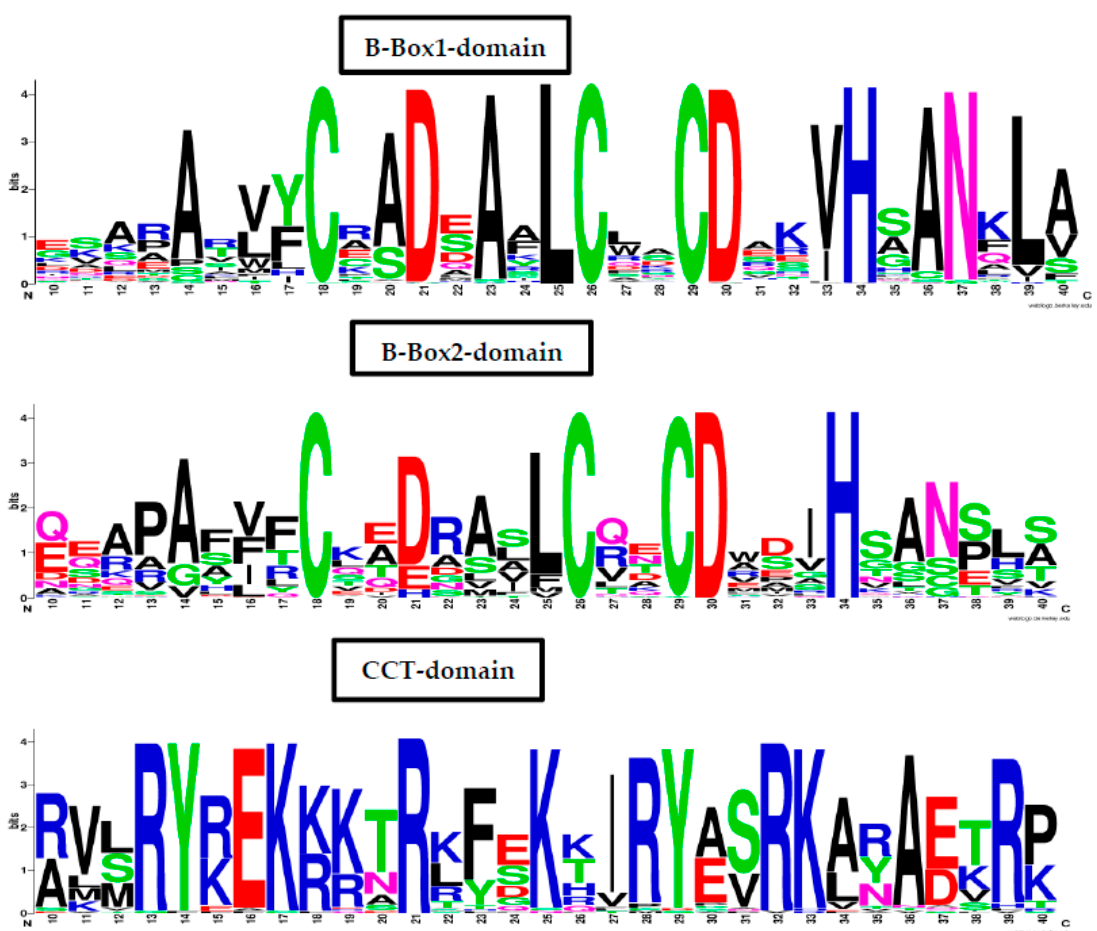
Figure 3. The web-logos B-Box 1, B-Box2, and CCT-domain of Rosacea BBX members.